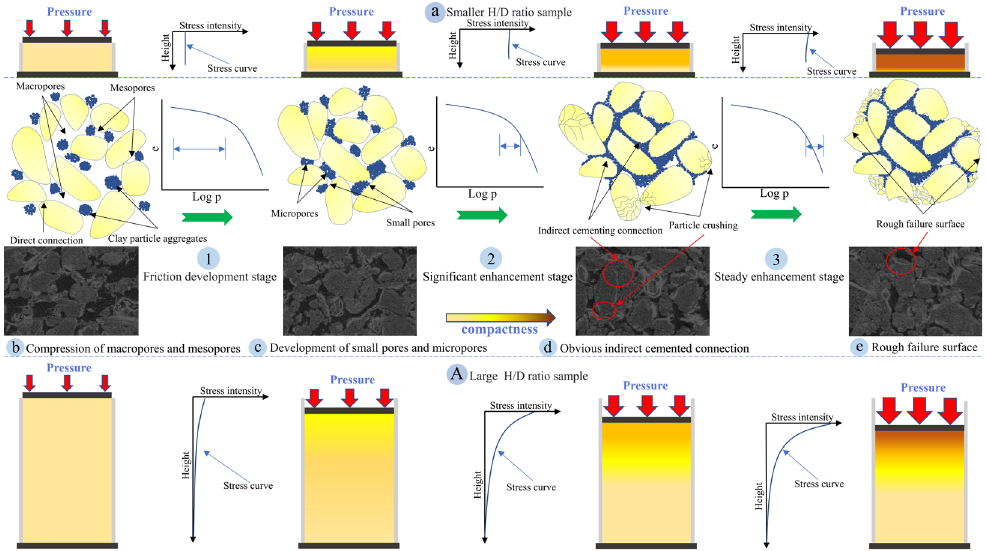
Figure 11. Schematic diagram of the development of soil–ring wall friction during compression.